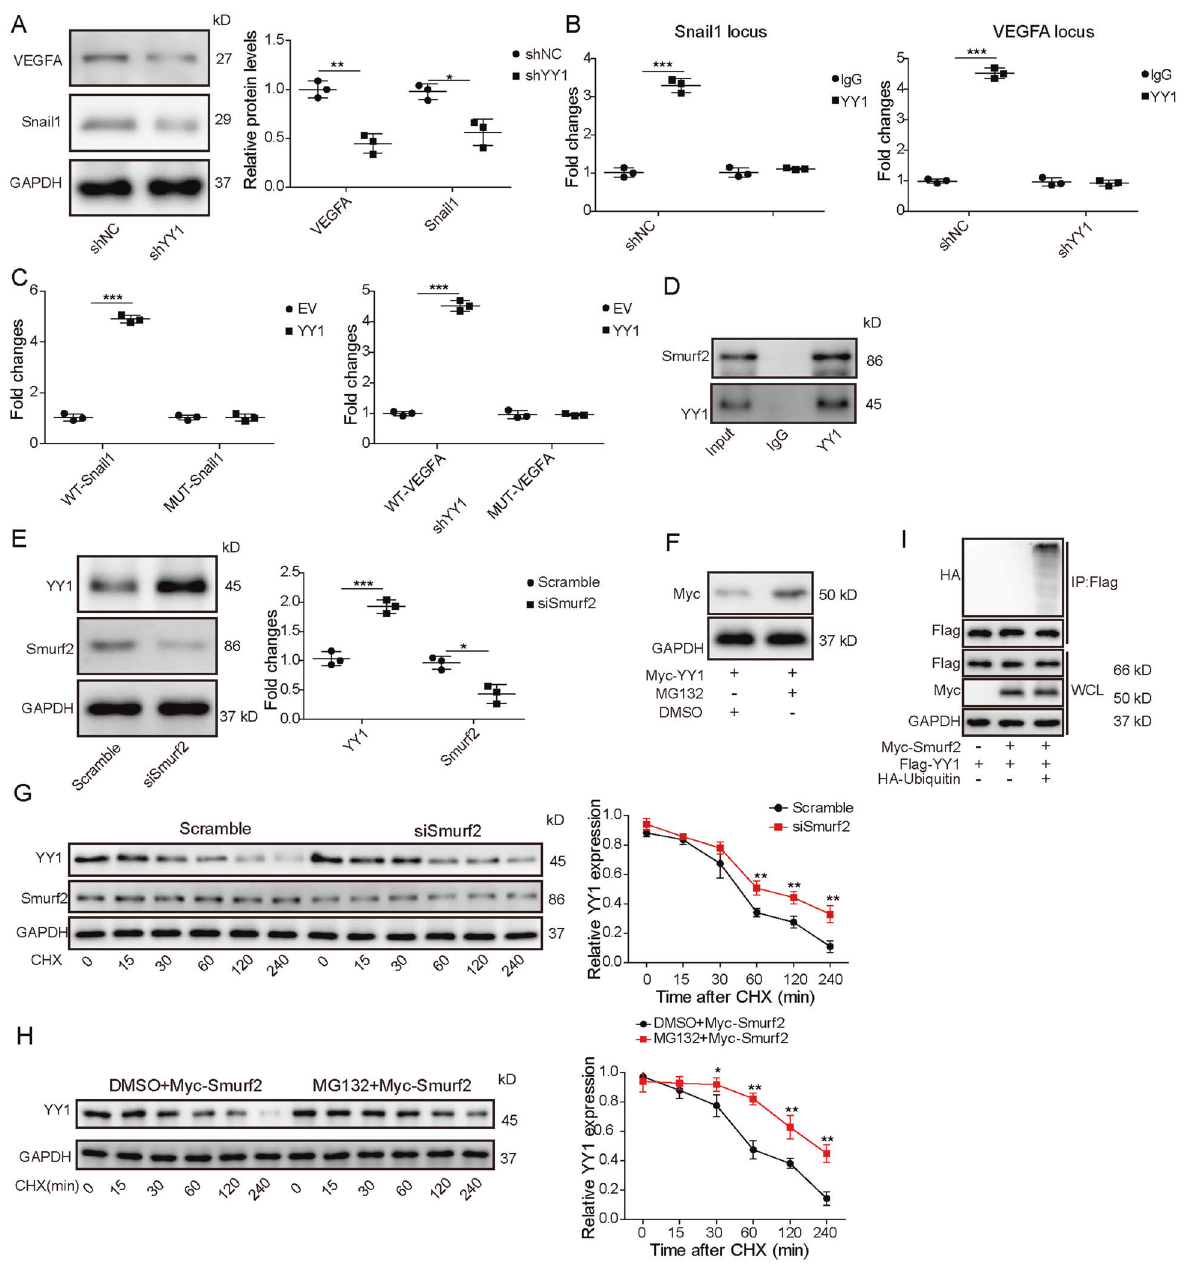
Fig. 4 YY1 binds with VEGFA and Snail1, and ubiquitination and degradation of YY1 are mediated by Smurf2. A VEGFA and Snail1 levels were detected by western blotting in ARPE-19 cells transfected with shNC or shYY1. B The binding of YY1 on the promoter of VEGFA and Snail1 was analyzed by ChIP in ARPE-19 cells transfected with shNC or shYY1. C Luciferase activity was measured in ARPE-19 cells co- transfected with empty vector (EV) or YY1 overexpression vector and WT-Snail1, Mut-Snail1, WT-VEGFA, or Mut-VEGFA. D Smurf2 and YY1 levels were detected by western blotting after Co-IP of YY1 antibody. E YY1 and Smurf2 levels were measured via western blotting in ARPE-19 cells transfected with siSmurf2 or Scramble. F Western blotting analysis of YY1 levels in WCL derived from HEK293T cells with or without MG132 treatment. G YY1 and Smurf2 levels were examined by western blotting in ARPE-19 cells transfected with siSmurf2 or Scramble before treatment of cycloheximide (CHX) for different time points. H Smurf2-overexpressed HEK293T cells were treated with CHX for 0, 15, 30, 60, 120, and 240 min in the presence of MG132 (a proteasome inhibitor), followed by the detection of YY1 using western blotting. I Expression vectors encoding Flag-YY1 and HA-ubiquitin were co-transfected into HEK293T cells transfecting Myc-Smurf2 and cell lysates were subjected for Co-IP using anti-Flag, which was followed by western blotting using anti-HA antibody. For each analysis, three technical replicates were performed and three biological independently performed replicates are included, * p < 0.05, ** p < 0.01, *** p <